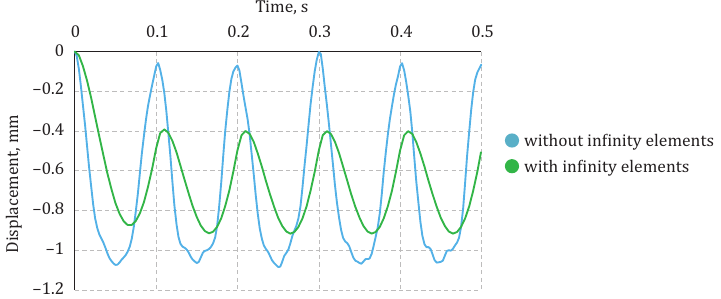
Figure 5. Dependence of the vertical displacements on